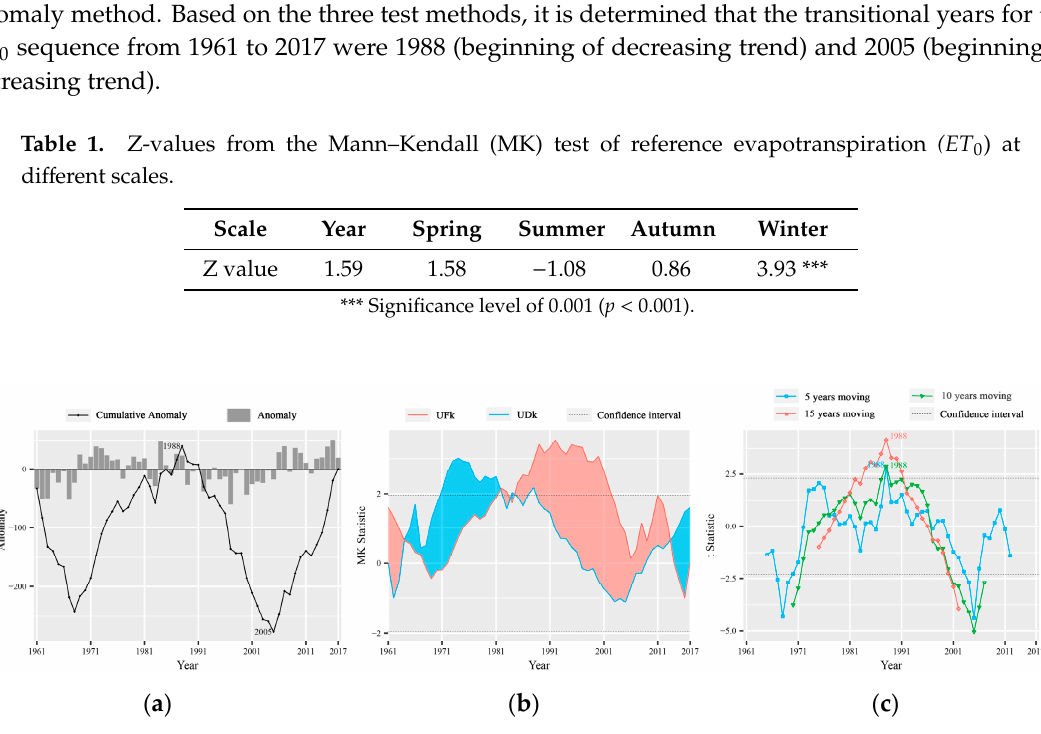
Figure 2. The abrupt change point identification diagram of the reference evapotranspiration ( ET 0 ) sequence, where ( a ) is the cumulative anomaly curve; ( b ) is the positive and negative sequence line of the Mann–Kendall (MK) test; and ( c ) is the sliding t -test curve with three steps, and the corresponding color is marked as the peak value of each